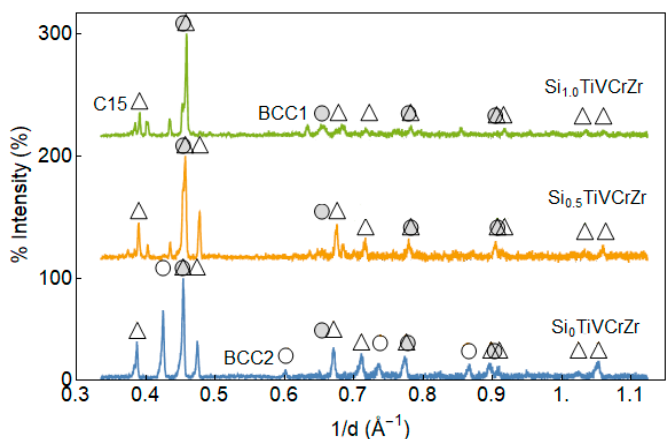
Figure 6. The X-ray di ff raction (XRD) patterns recorded for TiVCrZr-Si x ( x = 0, 0.5, 1.0) in the as-cast state. Triangles indicate peaks corresponding to the C15 Laves phase and circles indicate peaks corresponding to the disordered body-centred cubic (BCC) phase of which two are identified (shaded and non ‐ shaded).